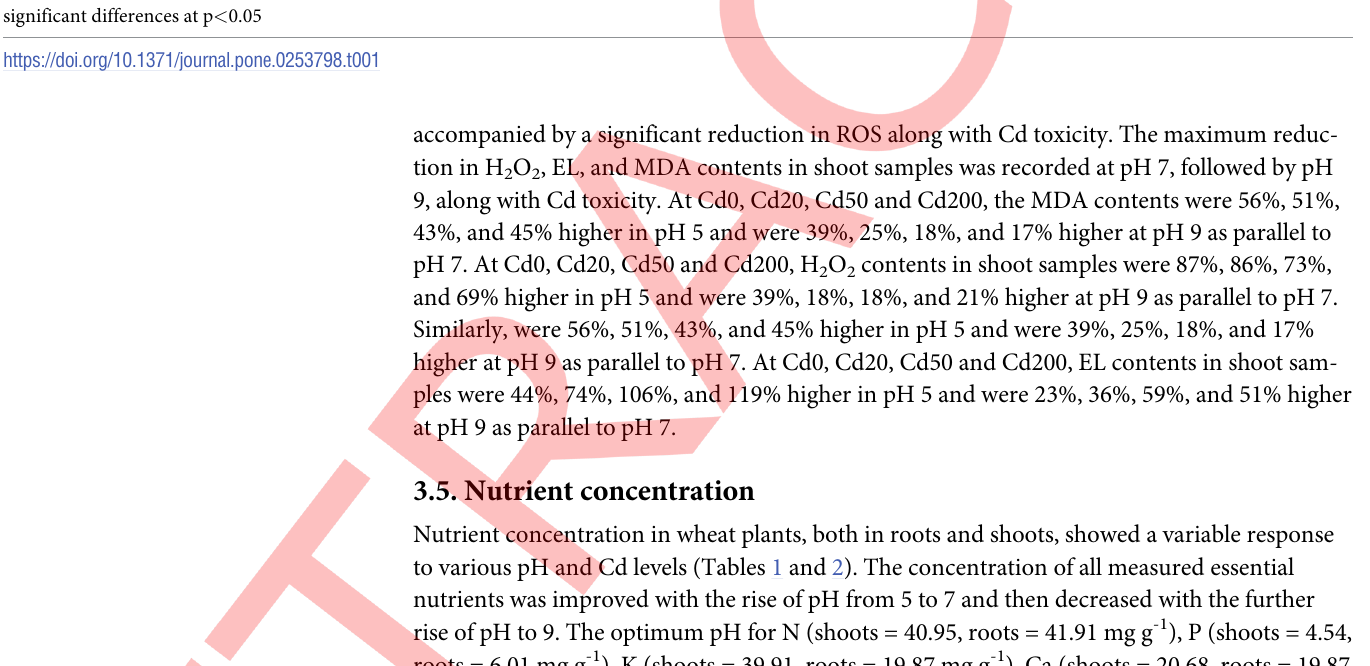
The values are expressed as the mean ± SD of three random replications of two independent experiments. The different superscript letters within a column indicate significant differences at p <